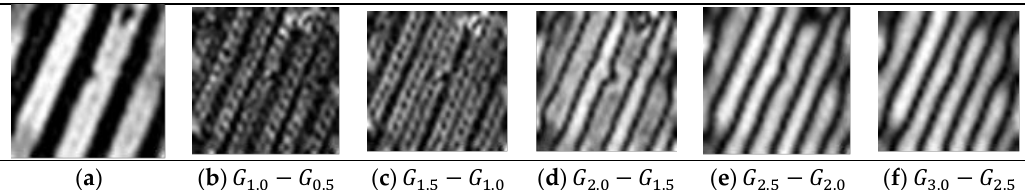
Figure 3. The results of Mean and standard deviation of contrast feature extracted from 50 zebra crossing samples (red crosses) and 50 background samples (blue crosses) based on the original images.